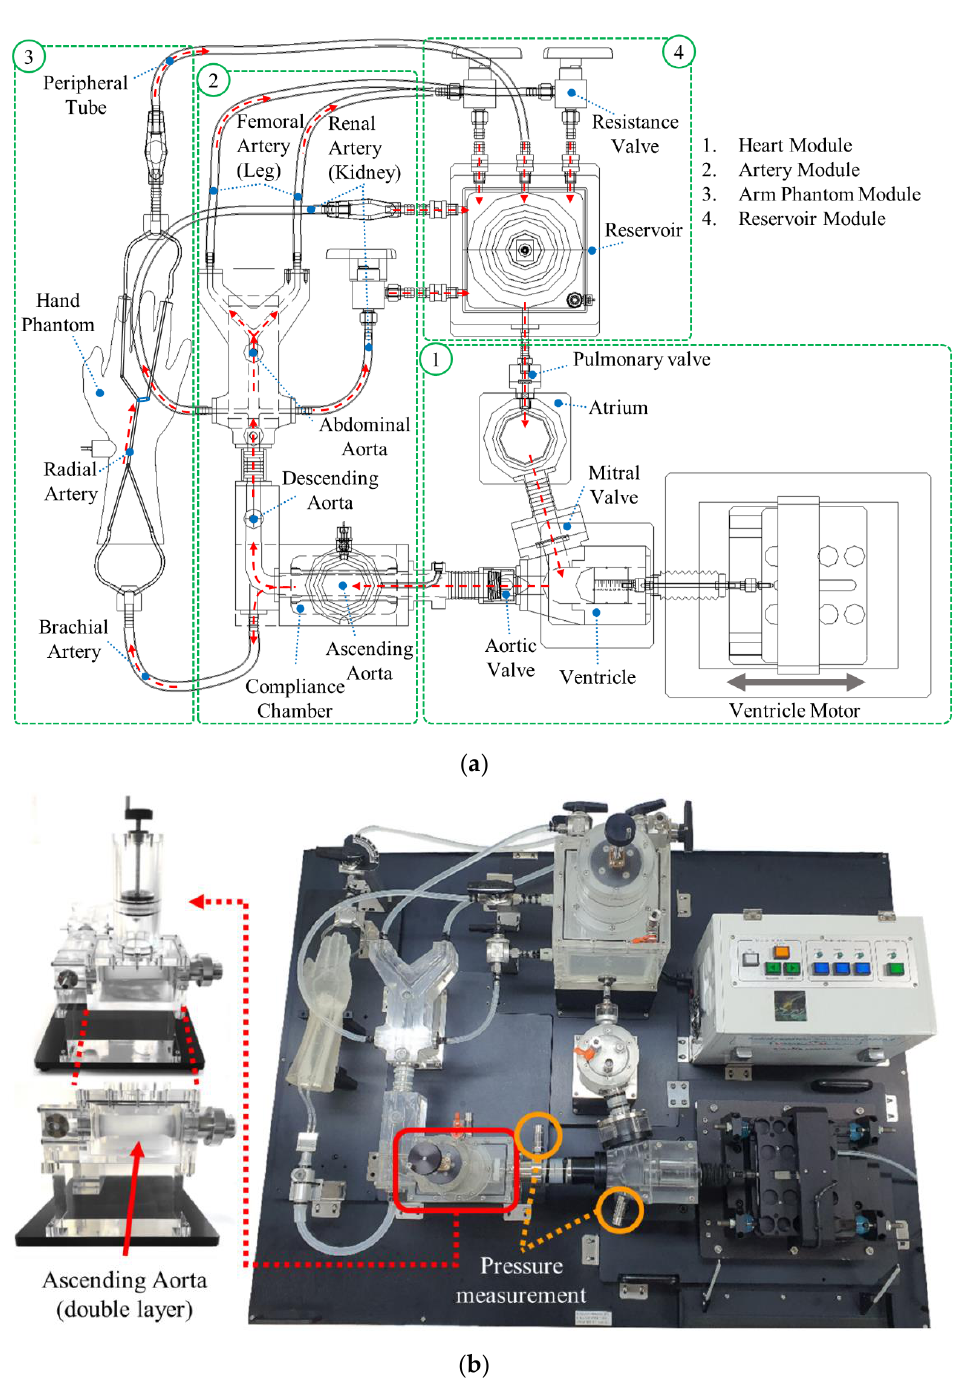
Figure 4. Design of mock circulatory platform: ( a ) drawing; ( b ) fabricated platform.